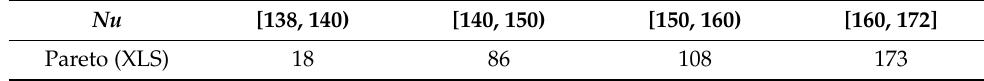
Table 5. The distribution for Pareto solutions of Nu for Op-II.